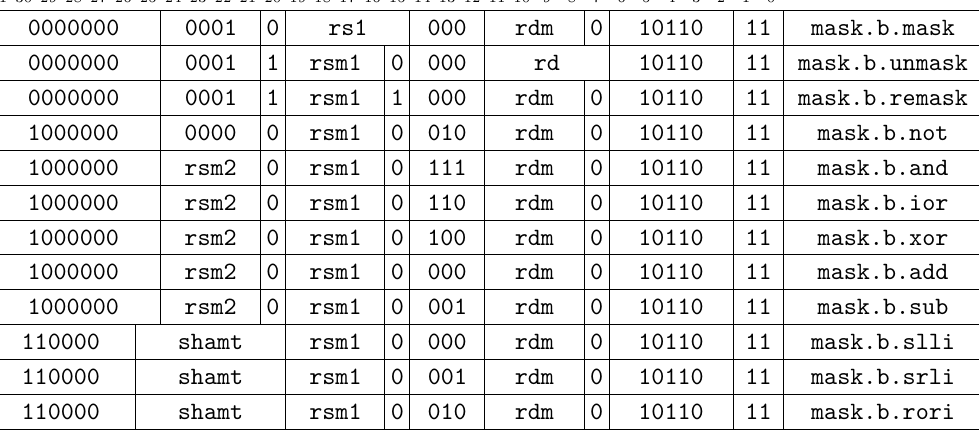
Table 7: Instruction encodings (B-class: operations under Boolean masking).